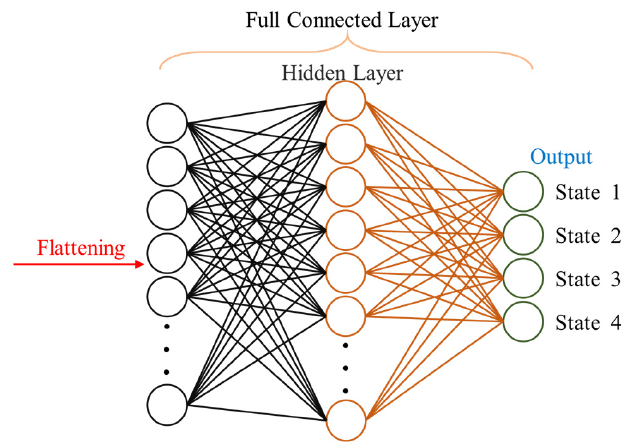
Figure 5. Schematic diagram of the pooling layer operation .